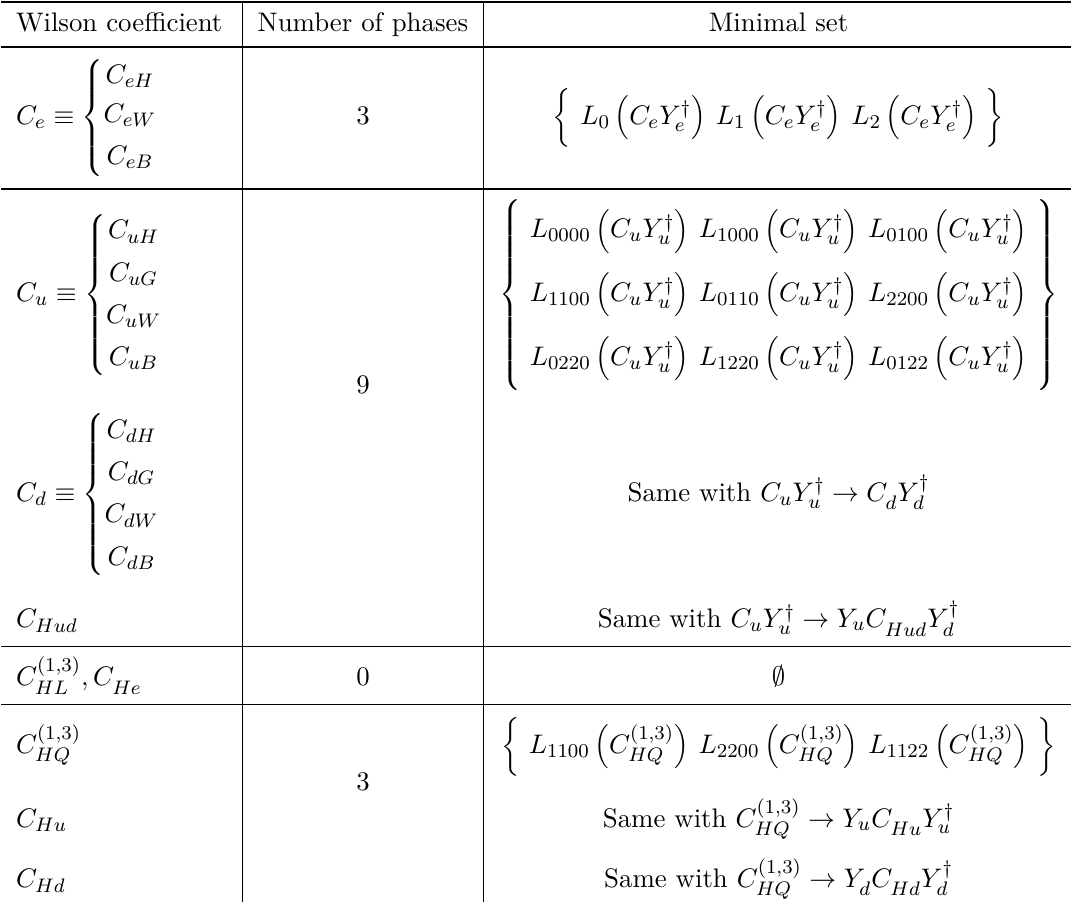
Table 10 . Minimal sets of CP-odd flavor invariants for all SMEFT dimension-six Wilson coefficients associated to operators bilinear in fermion fields. We recall that X u ≡ Y u Y † down quarks or electrons. We also recall the definition in eq. (4.1). We also defined for the